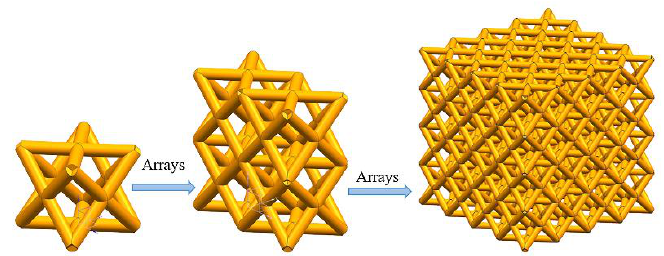
Figure 2. FCC structural porous bone scaffolds modeling process.